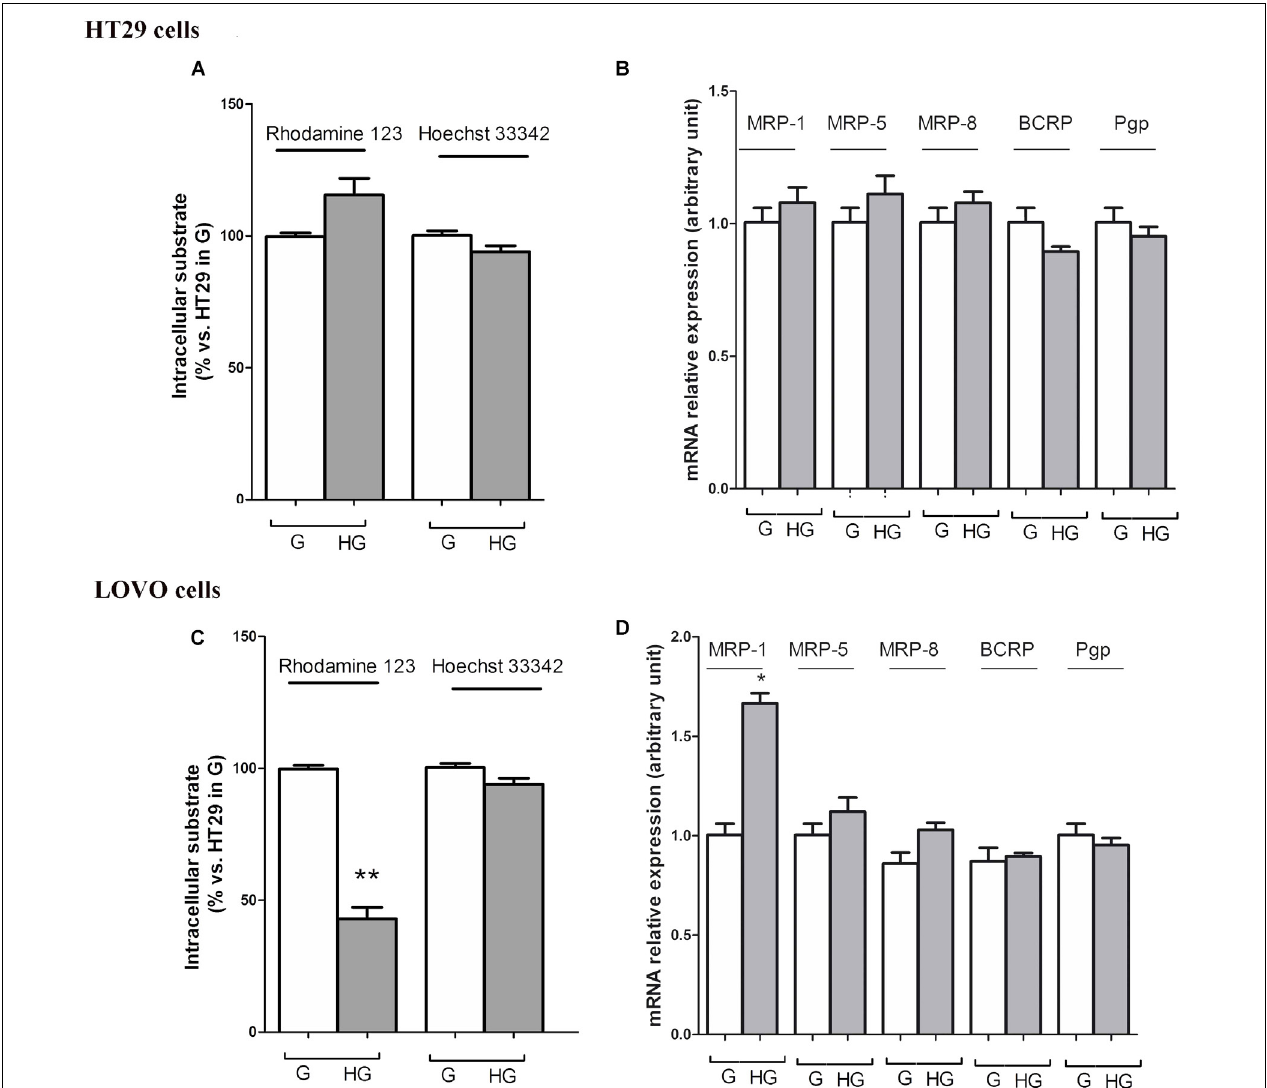
FIGURE 7 | ATP binding cassette transporters activity (A,C) and levels of messenger RNA (mRNA) (B,D) of MDR-related proteins (such as BCRP and MRP1, 5 and 8) and P-glycoprotein (Pgp) genes in normal glucose (G) and high glucose (HG) in human colon cancer (HT29 and LOVO) cells. (A,C) Cells were cultured for ≥ 7 days in the presence of G and HG, then washed and maintained for further 20 min at 37 ◦ C in fresh medium or DBPS buffer, respectively, containing rhodamine 123 (to assess Pgp and MRP activity) or Hoechst 33342 (to assess BCRP activity). The cells were lysed and the intracellular fluorescence, inversely related to its efflux, was assessed fluorimetrically. Measurements ( n = 6) were performed in triplicate. ∗∗ p < 0.001 LOVO cells cultured in HG vs. LOVO cells cultured in G. (B,D) At the same experimental conditions cells were analyzed by quantitative real-time polymerase chain reaction (RT-qPCR). Measurements ( n = 6) were performed in triplicate, and data, expressed as relative expression, are presented as means ± SEM; ∗ p < 0.01 LOVO cells cultured in HG vs. LOVO cells cultured in